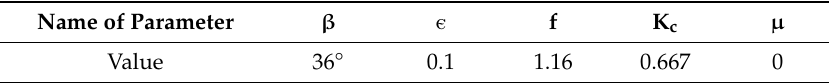
Table 5. The default parameters of the concrete damaged plasticity (CDP) model in the complex stress state.